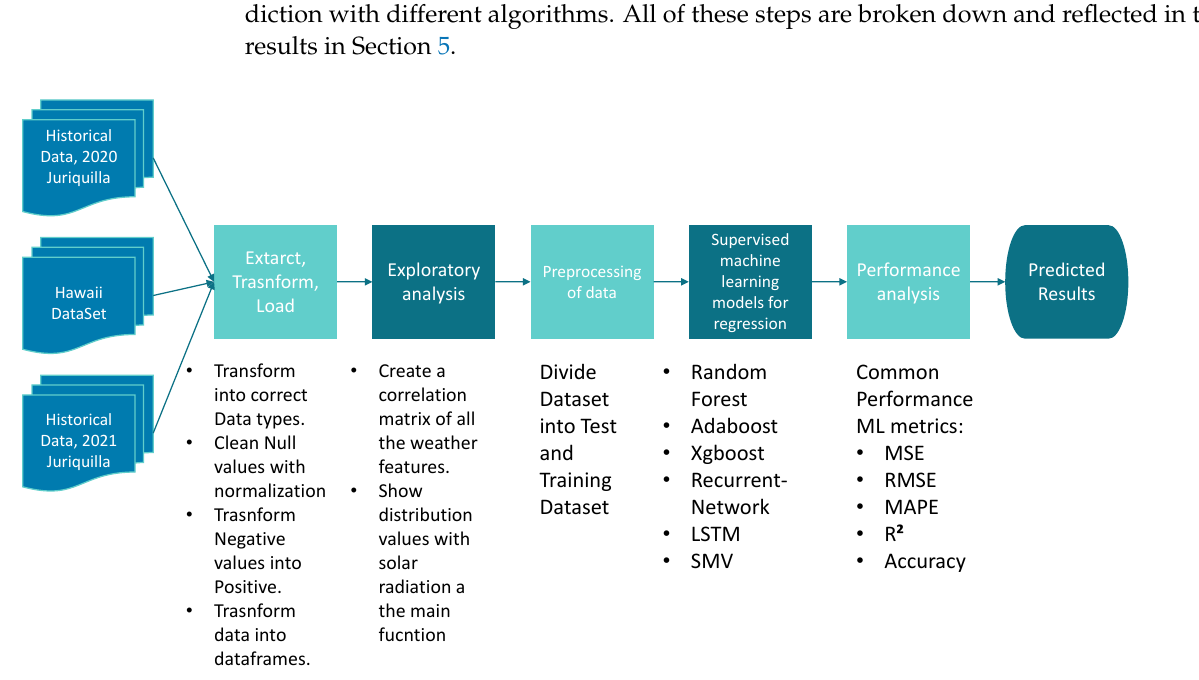
Figure 4. Graphical representation of the